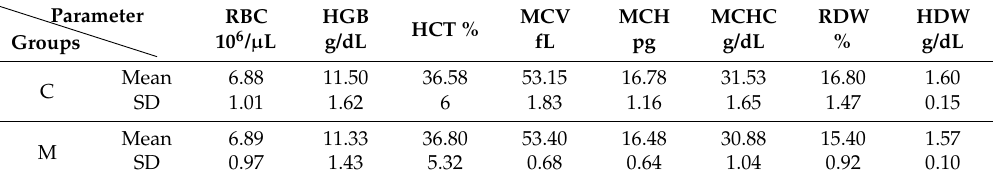
Table 3. Erythrogram of the peripheral blood of pigs from groups C and M.